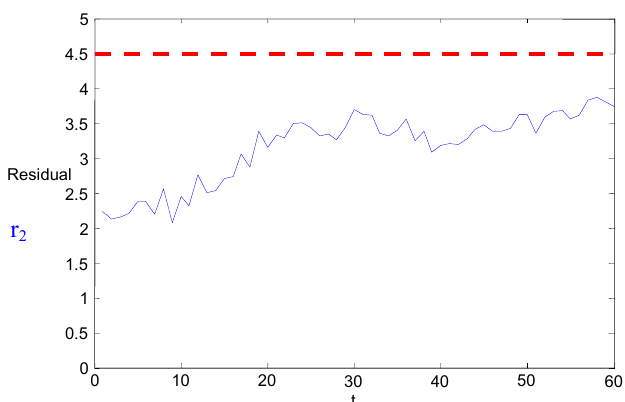
for position estimation sequence with initial standard deviations of Figure 7. Residual r 2 UDev = 5.8 and VDev = 6.1, and threshold level of